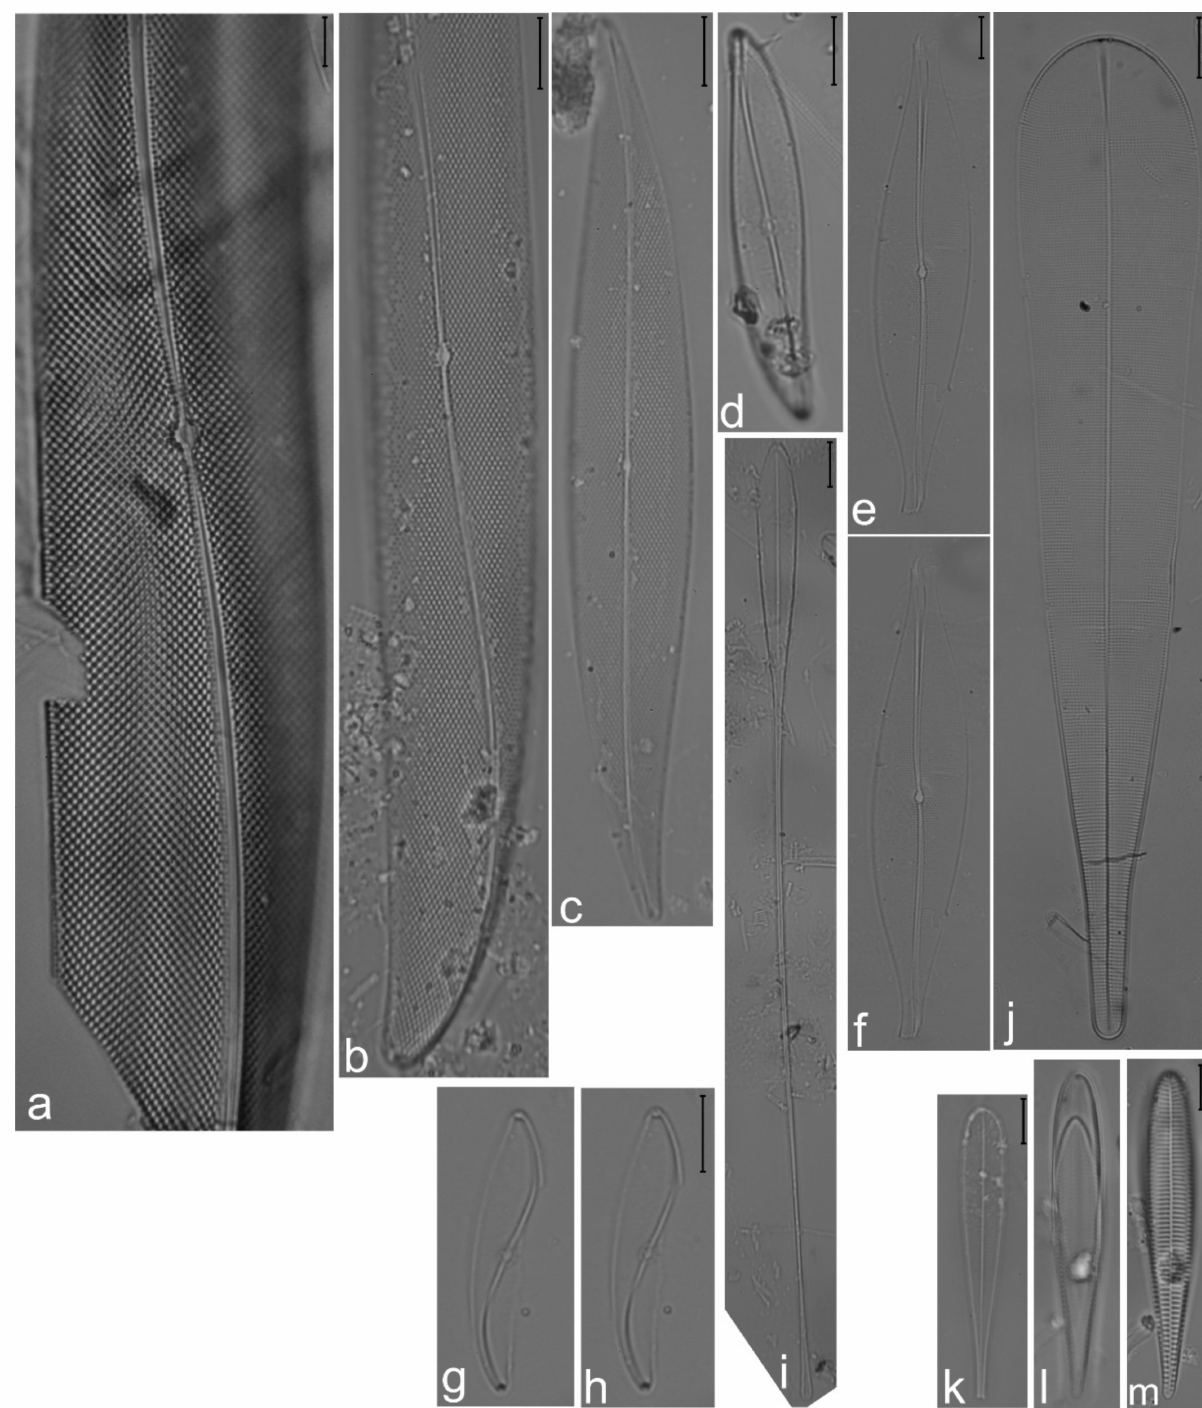
Figure 27. ( a , b ) Pleurosigma formosum ; ( c ) P . salinarum ; ( d ) P . obscurum var. diminuta , ( e , f ) P . rostratum ; ( g , h ) Rhoicosigma parvum ; ( i ) Licmophora remulus ; ( j ) L . paradoxa ; ( k ) L . gracilis ; ( l , m ) L . communis . Scale bar = 10 µ